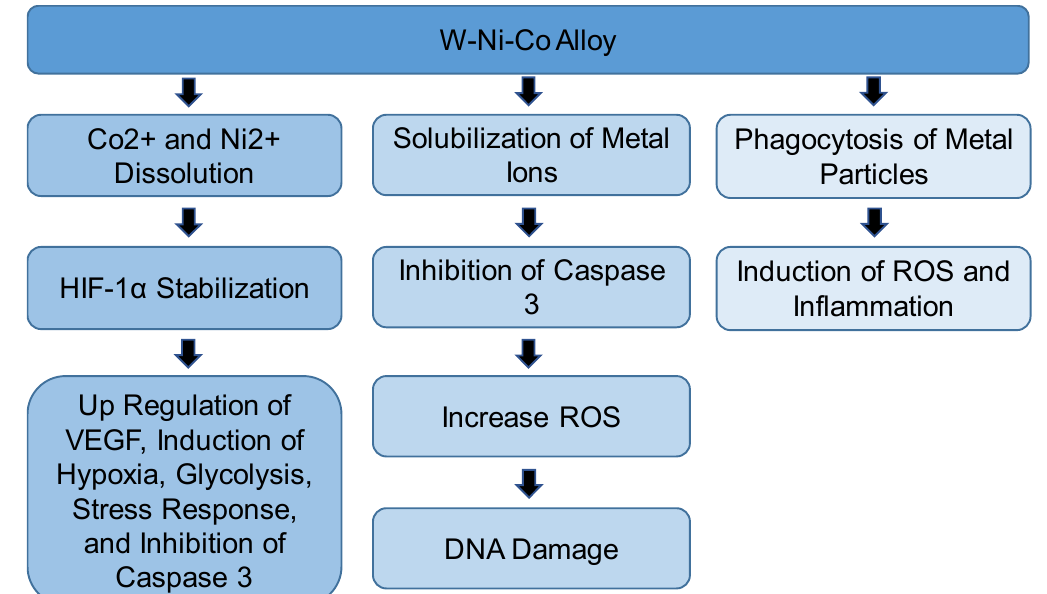
Figure 3. Summary of the proposed mechanisms and effects of the tungsten-nickel-cobalt (W-Ni-Co) alloy. HIF-1 α : hypoxia inducible factor 1- α ; ROS: reactive oxygen species; VEGF: vascular endothelial growth